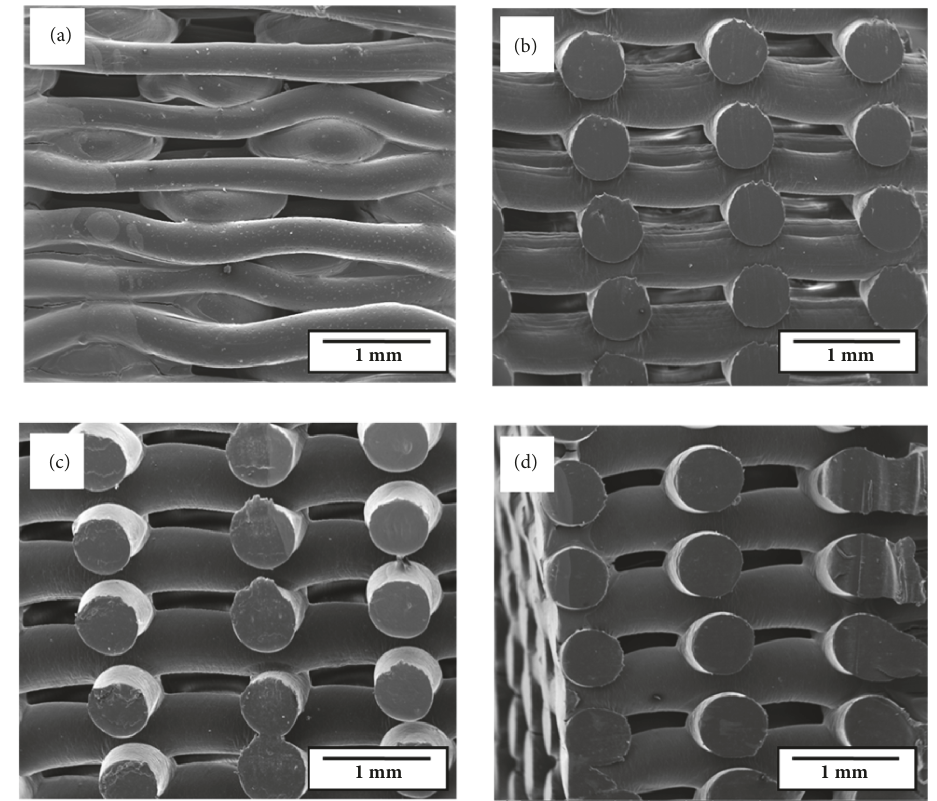
Figure 3: SEM images of the fabricated scaffolds: (a) lateral surface of PCL; and cross sections of (b) PCL + 1wt.% Biosilicate (cid:2) ; (c) PCL + 3wt.% Biosilicate (cid:2) ; (d) PCL + 5 wt.% Biosilicate (cid:2)